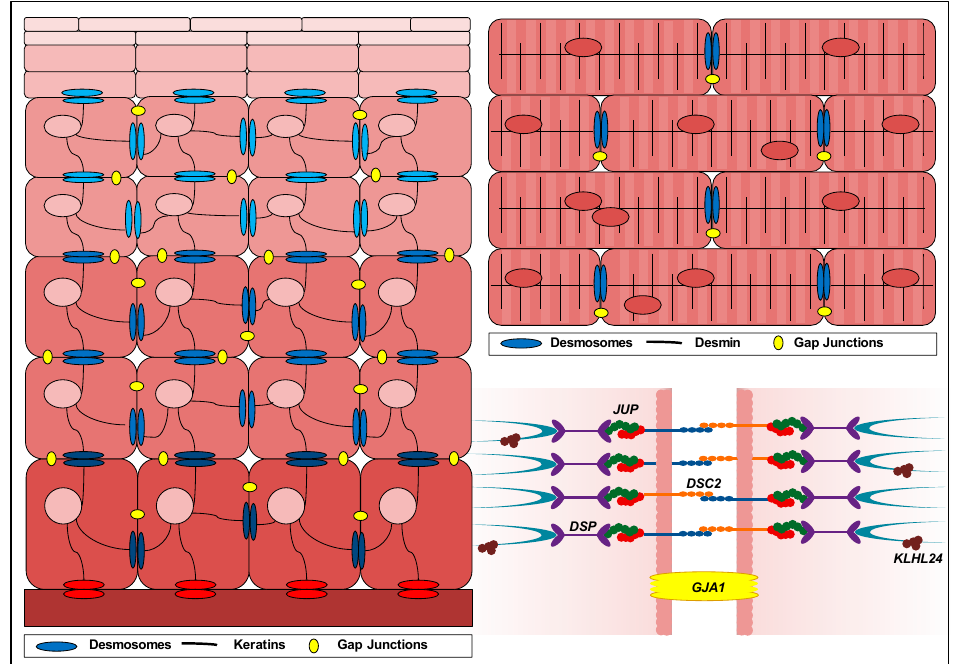
Figure 1. Schematic overview depicting the location of proteins causative for a cardiocutaneous syndrome. The left panel depicts continuously differentiating keratinocytes in the skin, migrating from the basement membrane towards the stratum corneum, where the terminally differentiated keratinocytes are localized. Keratinocytes are interconnected by gap junctions (in yellow) and desmosomes (in blue) that anchor the keratin intermediate filament network. Hemidesmosomes (in red) connect the basal keratinocytes to the underlying dermis. The upper right panel depicts a zoomed-in fraction of the myocardial wall, where cardiomyocytes are interconnected by gap junctions and desmosomes at the intercalated disc. The lower right panel depicts a plasma membrane between two adjacent cells containing a gap junction, connexin 43 (gene GJA1, protein Cx43) and a desmosomal junction, consisting of desmoplakin (gene DSP, protein DP), plakoglobin (gene JUP, protein PG), desmocollins (subtype 2; gene DSC2 , protein DC2) desmogleins (blue protein structures) and plakophilins (red protein structures). Intermediate filaments (turquoise protein structures) adhere to the desmosomal junction. Kelch-like protein 24 (gene and protein KLHL24 ) mostly accumulates near the plasma